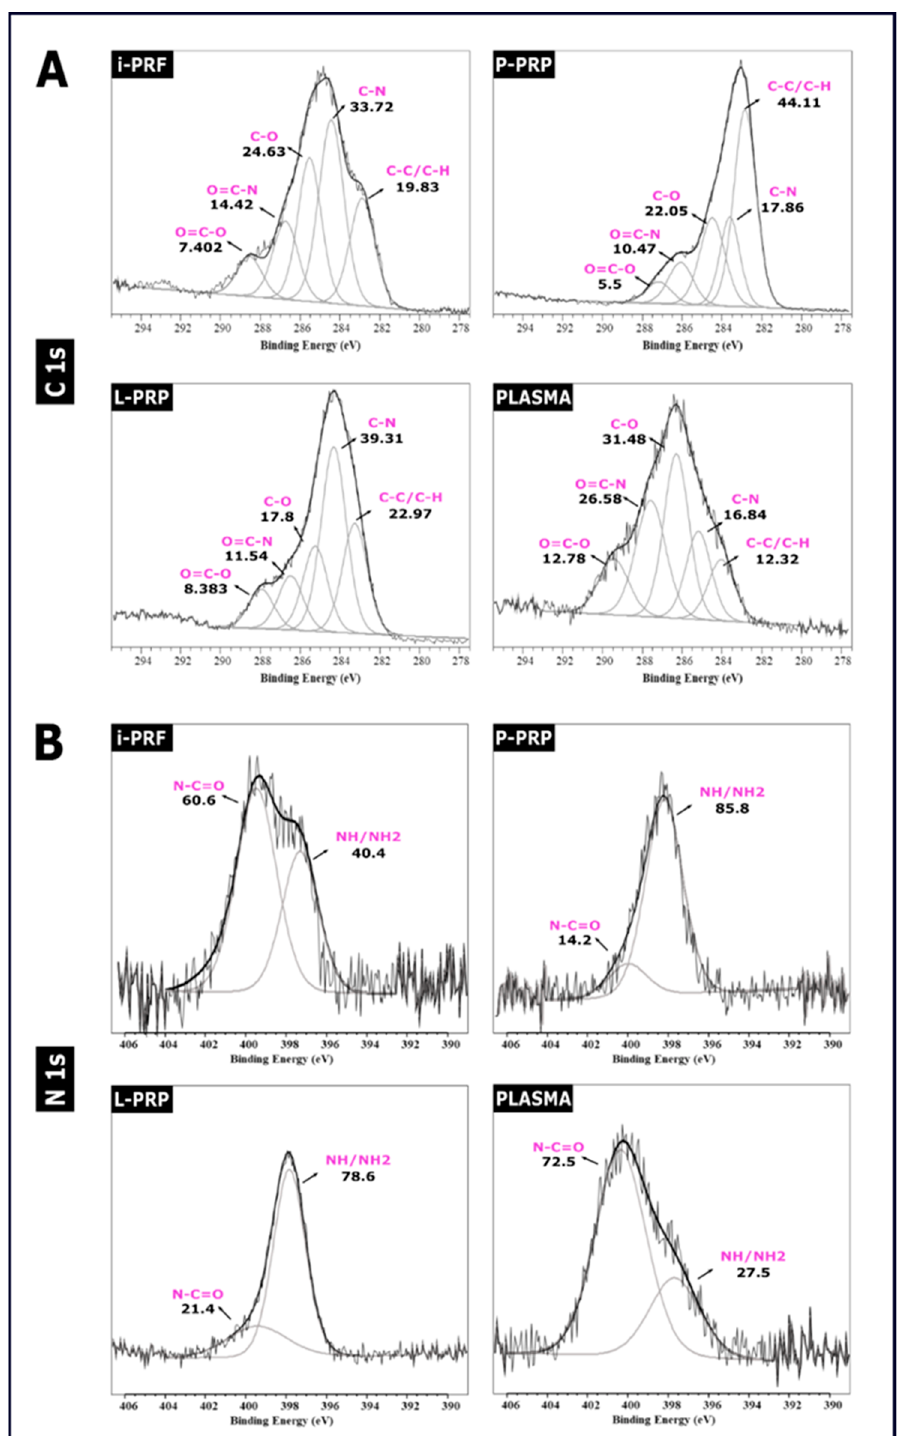
Figure 5. ( A ) C1s narrow scan and ( B ) N1s narrow scan XPS spectra for the different hemoderivatives on the PCL/CaP scaffold surface. Peak deconvolution of C1s and N1s of the different groups.